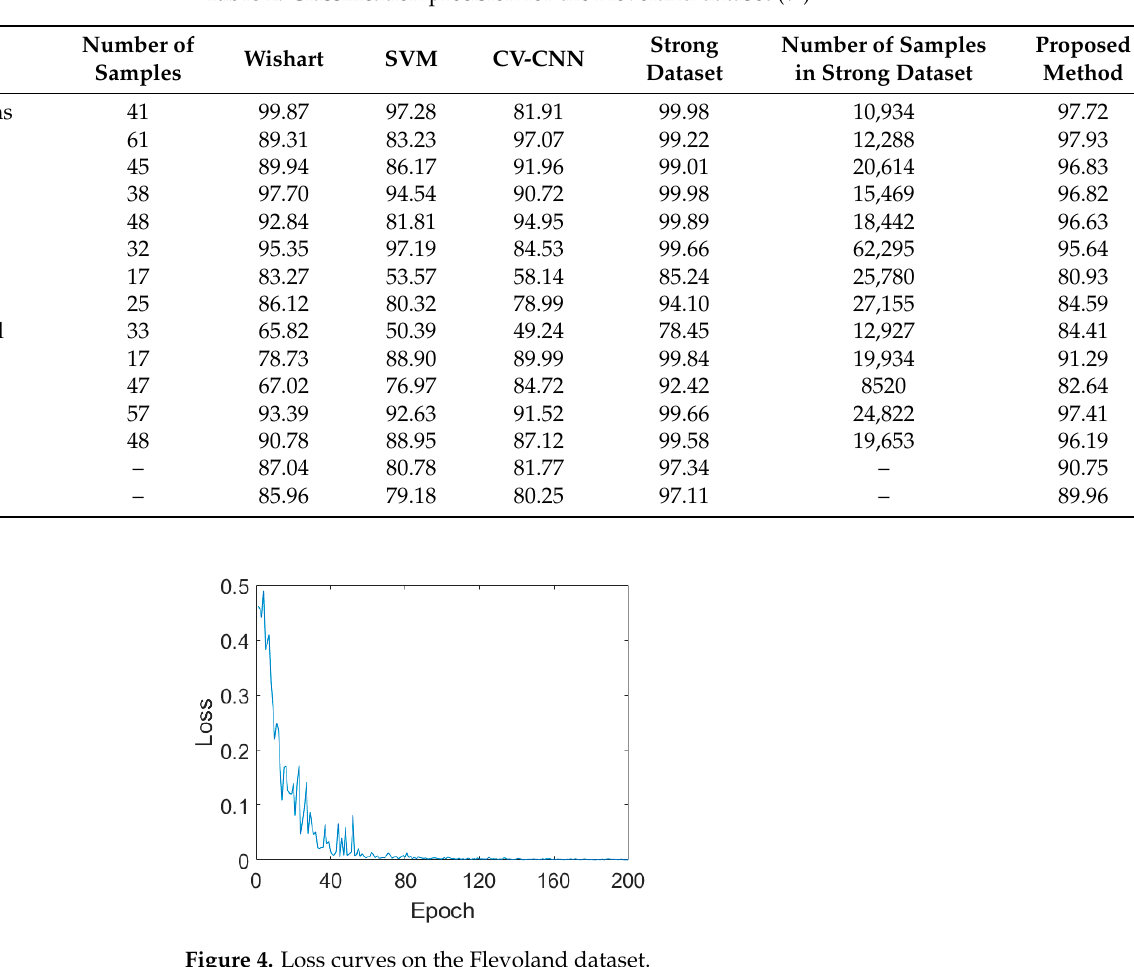
Table 2. Classification precision for the Flevoland dataset (%).